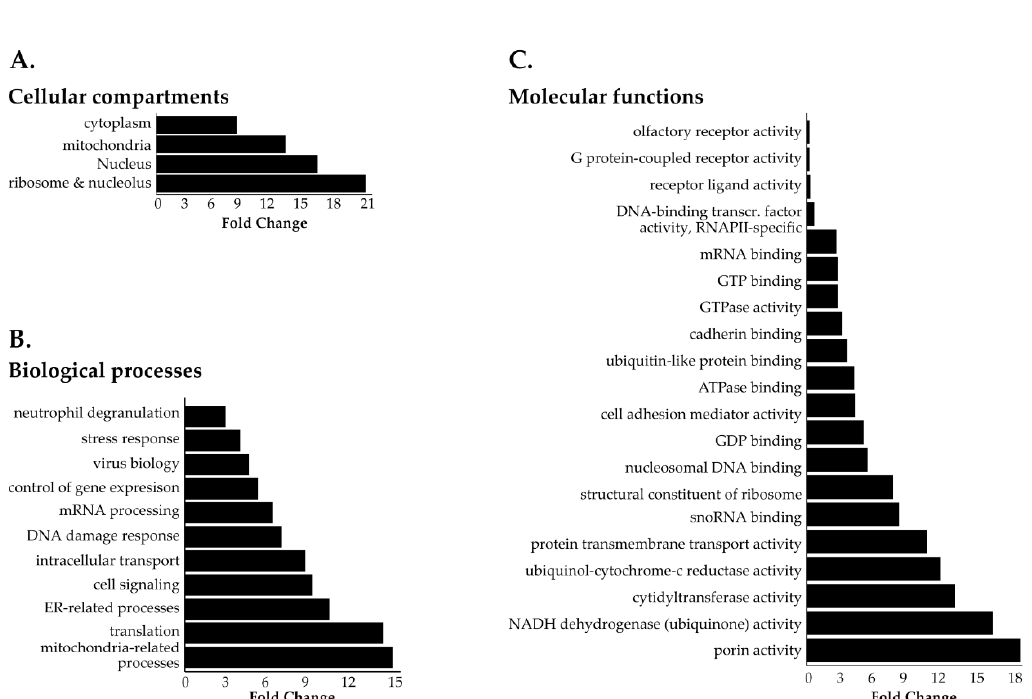
Figure 5. Gene ontology (GO) of SN214-BioID proximal interactors. Most represented ( A ) cellular compartments (GOCC), ( B ) biological processes (GOBP), and ( C ) molecular functions (GOMF) among SN214-BioIDproximalinteractors. StatisticalanalysisoftheoverrepresentedproteinsintheSN214-BioID fraction (total 1125 proteins) was performed with the PANTHER classification online software (v14.1) using Fisher’s exact test. Results are displayed for FDR p < 0.05. Summarized graphic representation of the significantly enriched GO terms among SN214-BioID proximal interactors. The detailed results of GOBP and GOCC analysis can be consulted in Figures S3 and